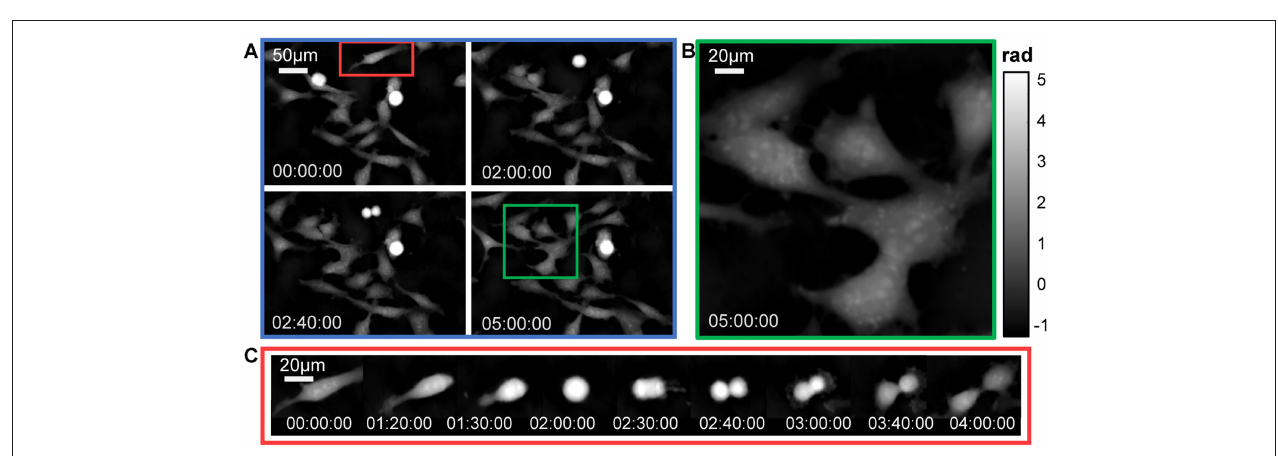
FIGURE 7 | Microlens array characterization using QPICWD. (A) QPICWD reconstructed phase under 20 × , 0.4 NA objective. (B) Reference speckle ( I R ( x )). (C) Sample speckle ( I S ( x )). (D) Recovered phase of single microlens by QPICWD [enlarged version of the red box area in (A) ]. (E) DHM (digital holographic microscope) reconstructed unwrapped phase under 20 × , 0.5 NA objective. (F) Phase line profiles corresponding to the red dashed line in (D) and the blue solid line in (E) , respectively.